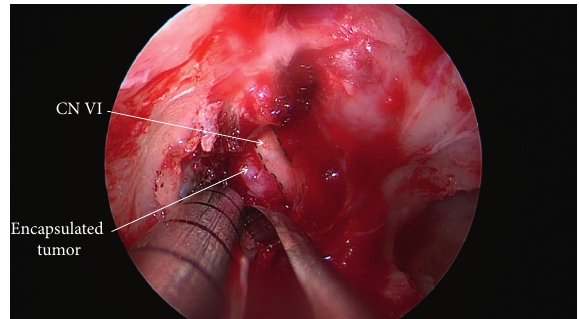
Figure 6: Visualization of the encapsulated epidermoid in a corridor inferolateral to the abducens nerve.